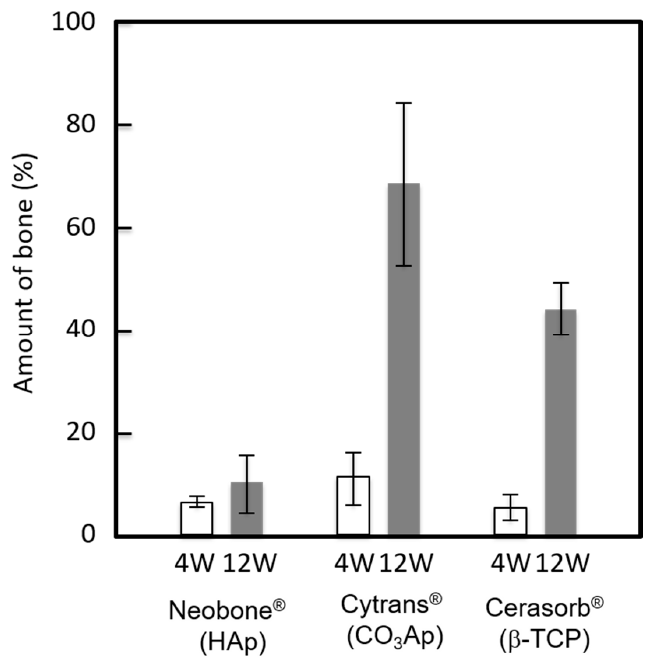
Figure 8. Amount of new bone formed in bone defect area at 4 weeks and 12 weeks after implantation. ( n = 2).